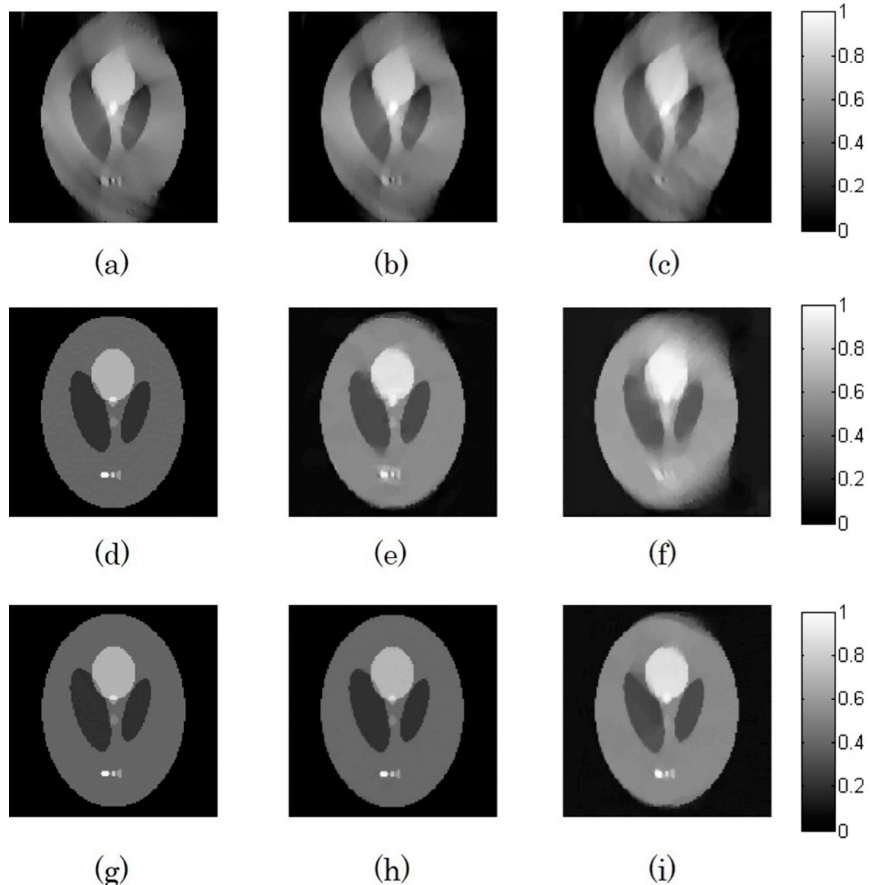
Figure 4. The reconstructed images from the straight-line scanning by the TV-GD (TV-based algorithm solved by gradient descent method), TV-VB (TV-based algorithm solved by the variable splitting and Barzilai–Borwein based method) and TV-GPEF (TV-based algorithm incorporated with Gerchberg-Papoulis-based FFT-utilized compensation method) algorithms: the first row refers to the results of the TV-GD ( a – c ); the second row refers to the results of the TV-VB ( d – f ); and the third row refers to the results of the TV-GPEF ( g – i ). The first to third columns refer to the results from: 50-points ( a , d , g ); 20-points ( b , e , h ); and 10-points ( c , f , i ) sampling, respectively.